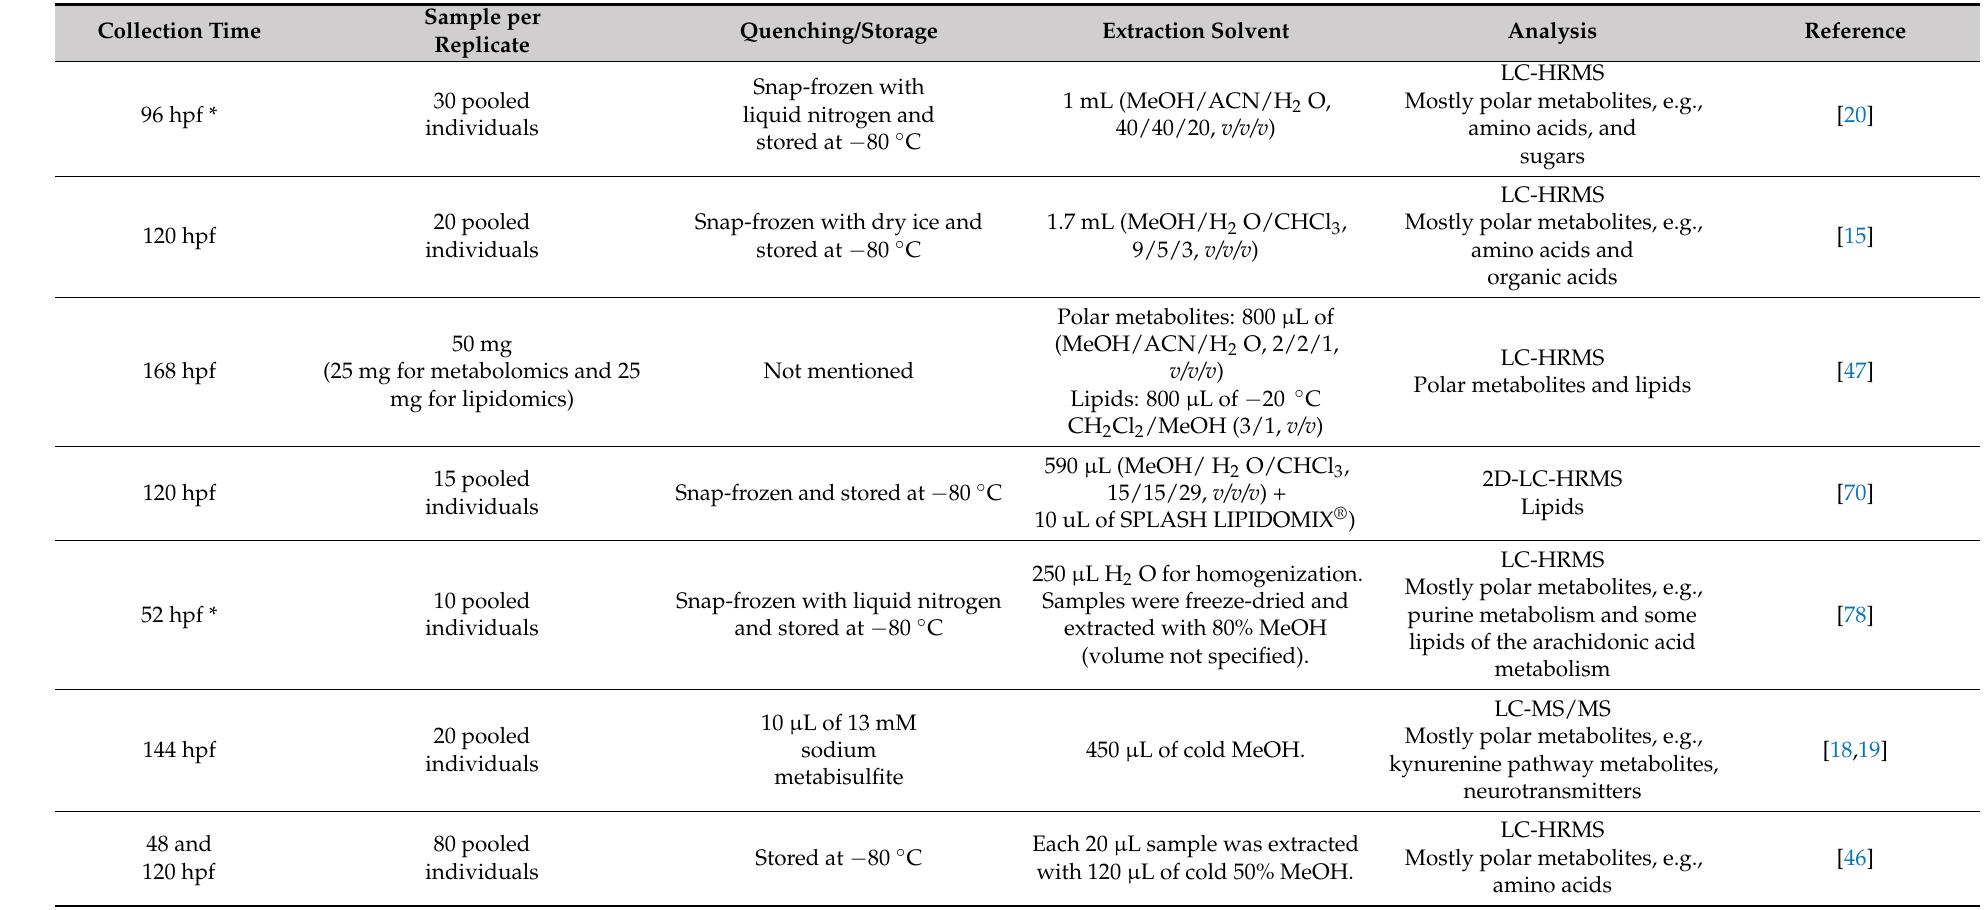
Table 1. Examples of recent studies using LC-MS metabolomics with zebrafish embryos, larvae, and